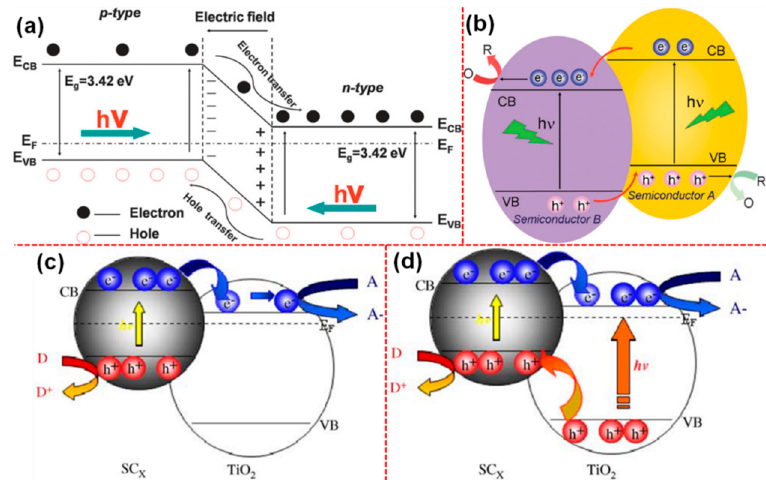
Figure 5. Schematic diagram showing the energy band structure and electron-hole pair separation in the ( a ) p-n heterojunction; ( b ) non p-n heterojunction; ( c ) energy diagram illustrating the coupling of two SC in which vectoral electron transfer occurs from the light-activated SC to the non-activated TiO 2 ; ( d ) diagram depicting the coupling of SC in which vectoral movement of electrons and holes is possible (reproduced with permission from refs. [107,109]).